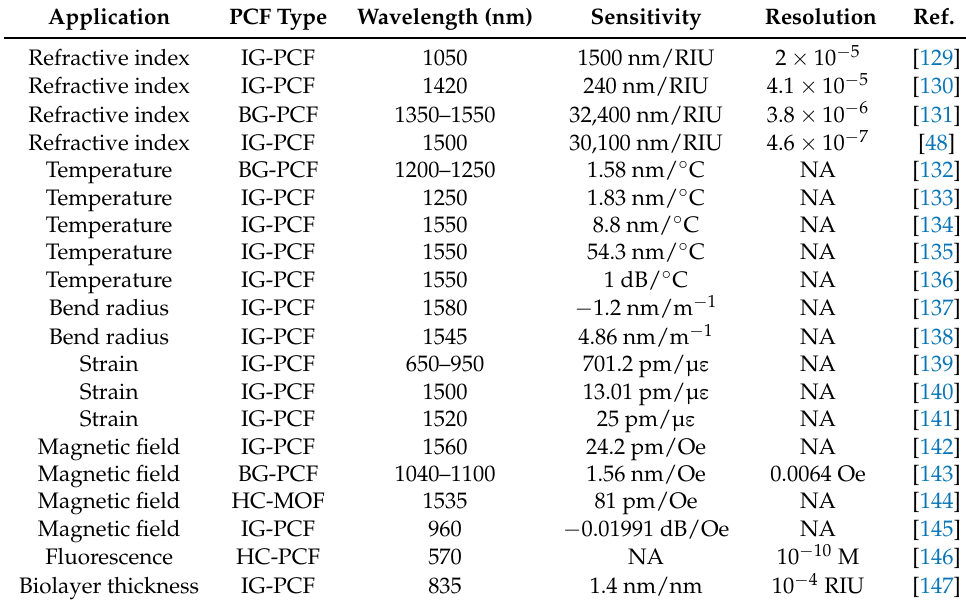
Table 2. Properties of most relevant liquid-infiltrated PCF